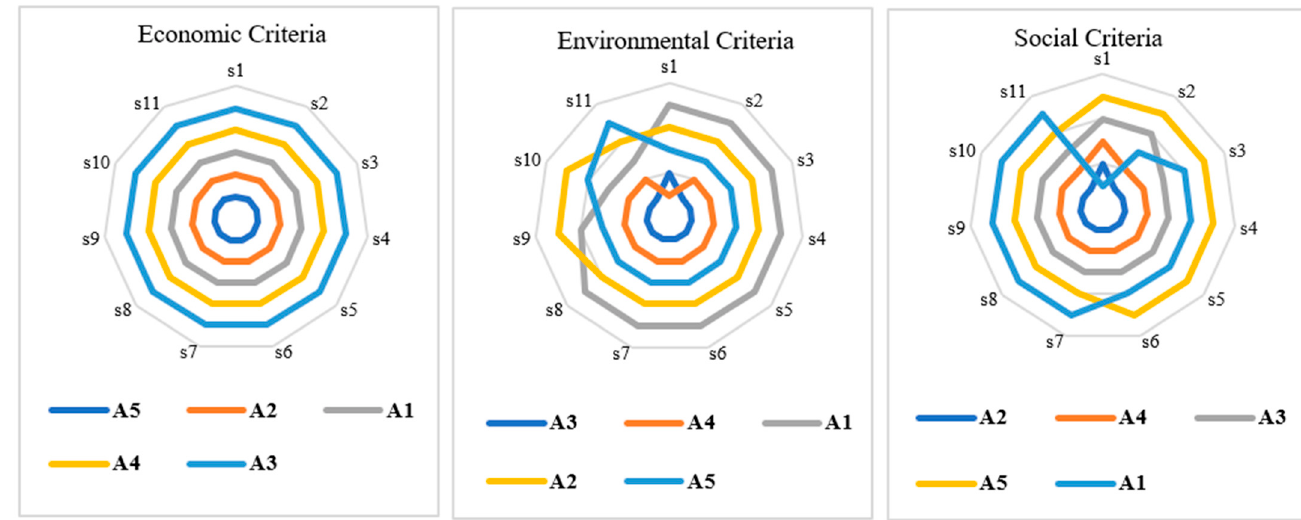
Figure 8. Sensitivity analysis of the ranks of alternatives in 11 scenarios.